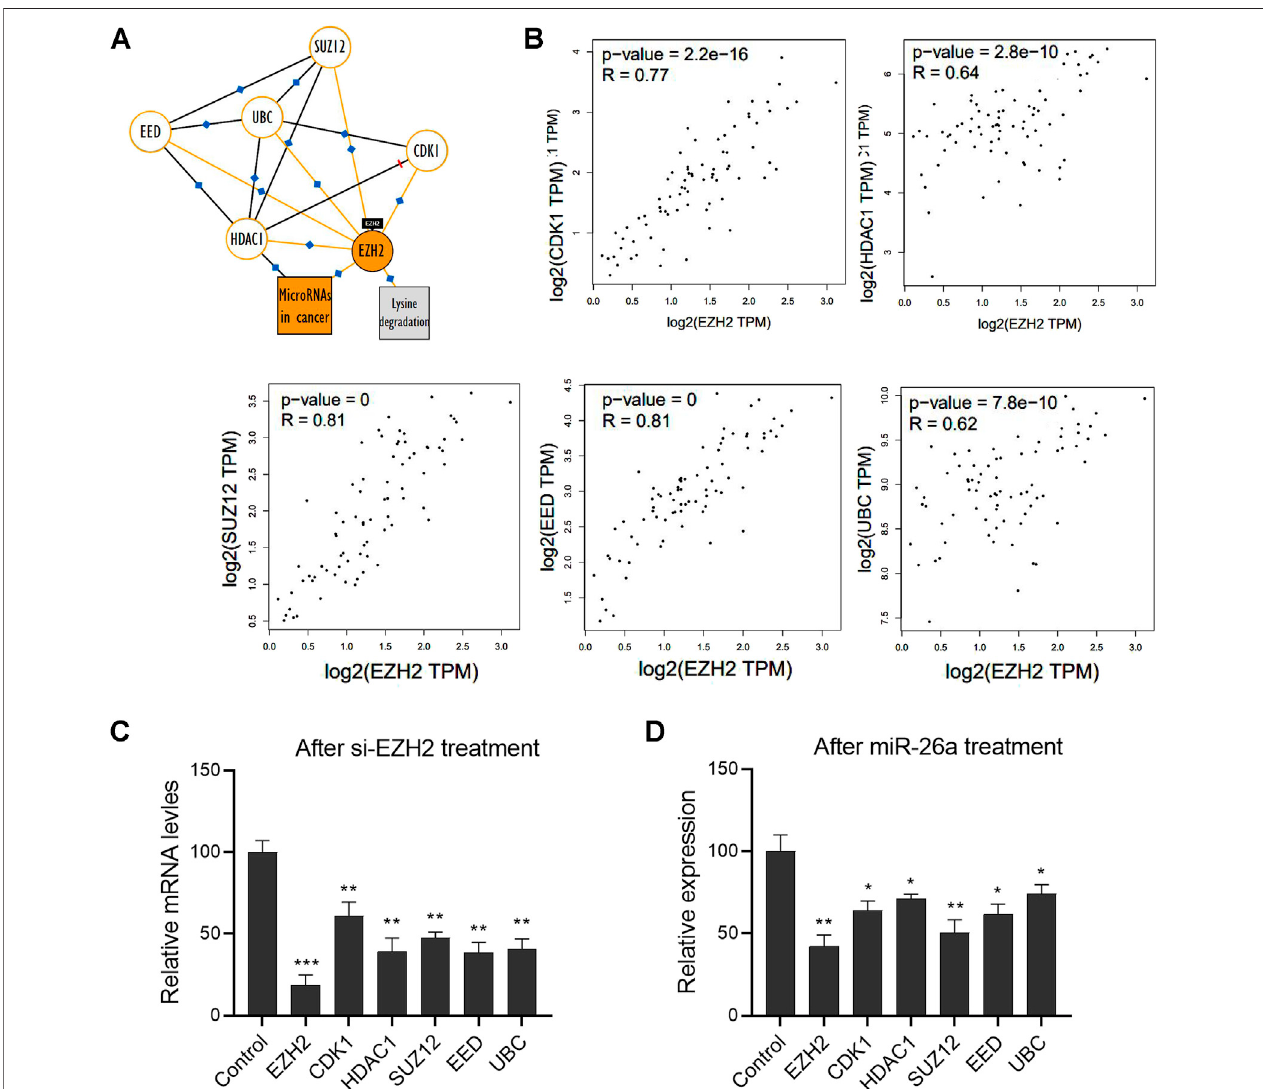
FIGURE 4 | A network of EZH2 and its interacting proteins participated in miR-26a-mediated tumor progression. (A) The Kyoto Encyclopedia of Genes and GenomespathwayanalysiswasperformedtoidentifypotentialinteractingpartnersofEZH2inUM. (B) TheinteractionbetweenEZH2andthesemoleculeswasanalyzed using the non-log scale for calculation and log-scale axis for visualization (Pearson ’ s correlation coef fi cient). (C) qRT-PCR analysis was performed to evaluate mRNA expressionin92.1cellsafterEZH2genesilencing. (D) AftertransfectionwithamiR-26amimic,mRNAlevelsofEZH2,UBC,CDK1,HDAC1,SUZ12,andEEDwere measured in 92.1 cells (* p < 0.05, ** p < 0.01, *** p <